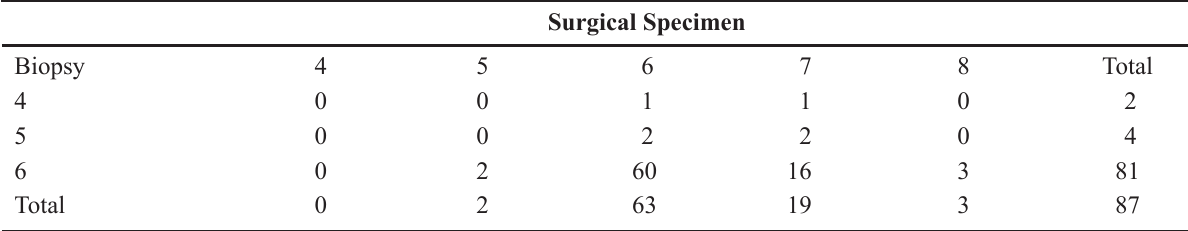
Table 3 – The comparison of Gleason scores between biopsy and surgical specimen in 87 cases.